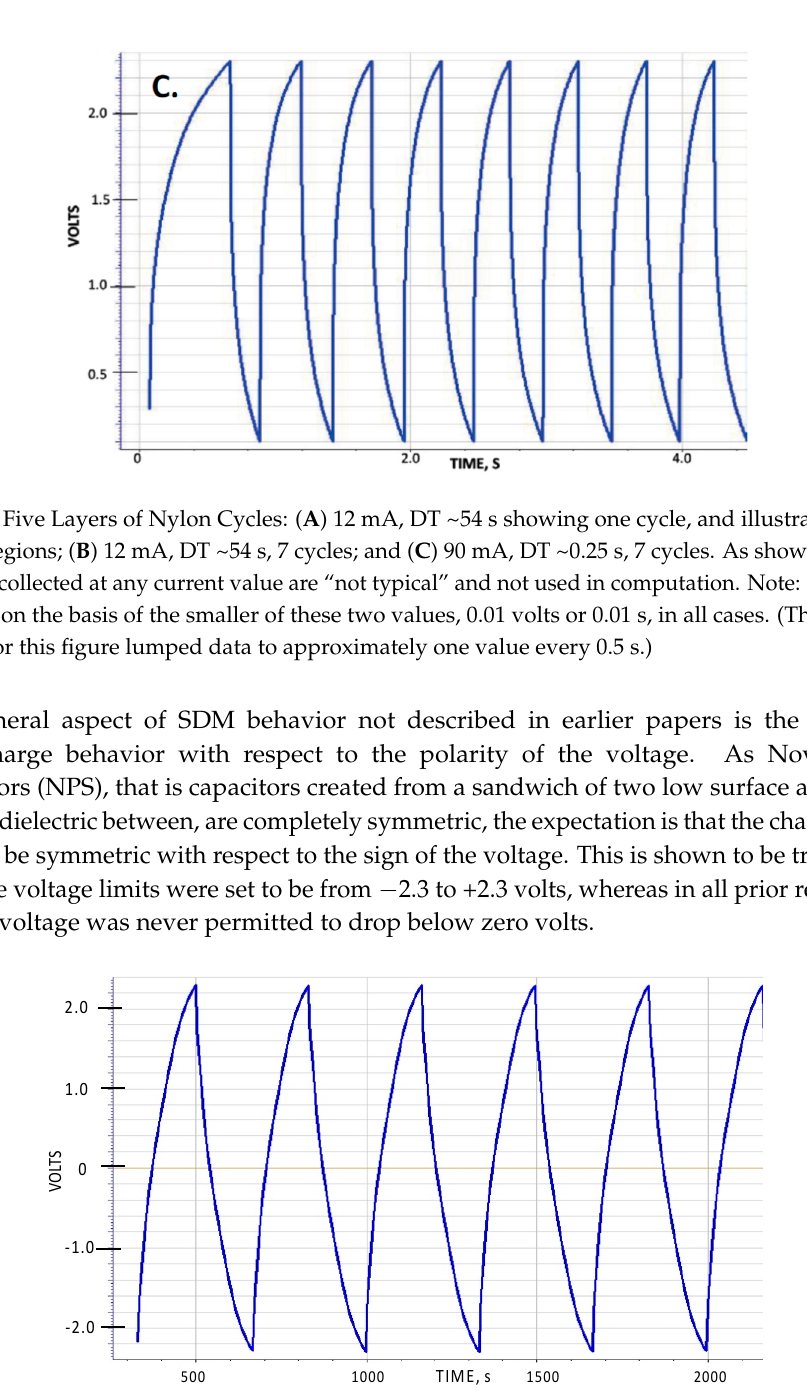
Figure 2. Symmetric Capacitance. NPS capacitors are symmetric, hence can be charged and discharged from − 2.3 to +2.3 Volts. Data shown are from a five-layer sample, operated at 12 mA constant current mode.